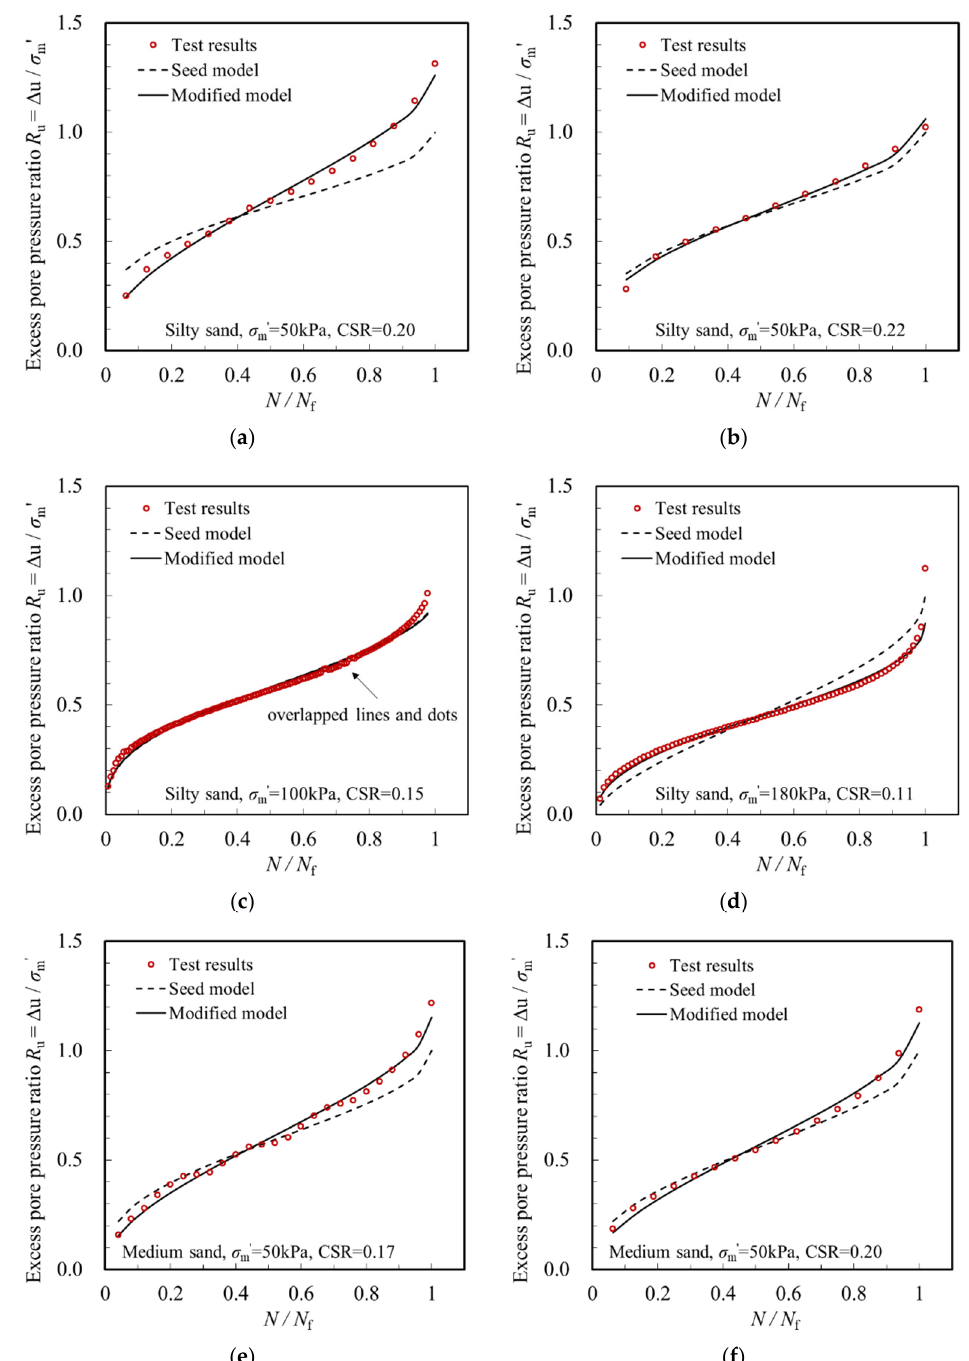
Figure 12. Comparison between predicted and test results about excess pore pressure of marine sand in the East Nao-ao area: ( a ) Silty sand, σ m ’ = 50 kPa, CSR = 0.20; ( b ) Silty sand, σ m ’ = 50 kPa, CSR = 0.22; ( c ) Silty sand, σ m ’ = 100 kPa, CSR = 0.15; ( d ) Silty sand, σ m ’ = 180 kPa, CSR = 0.11; ( e ) Medium sand, σ m ’ = 50 kPa, CSR = 0.17; ( f ) Medium sand, σ m ’ = 50 kPa, CSR = 0.20.